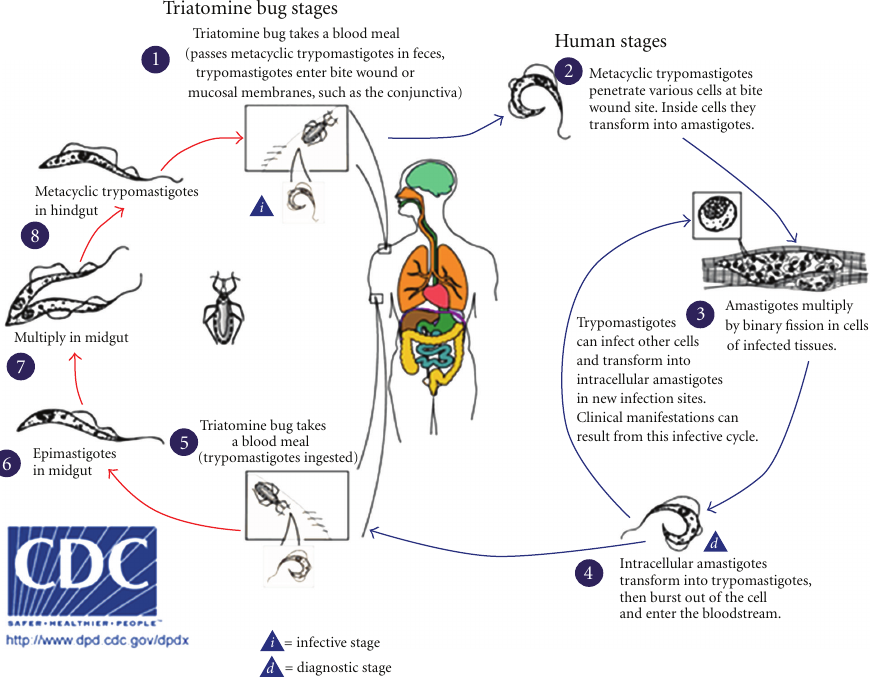
Figure 2: An infected triatomine bug takes a blood meal and releases trypomastigotes in its feces near the site of the bite wound. Trypomastigotes enter the host through the wound (1). Inside the host, the trypomastigotes invade cells near the site of inoculation, where they di ff erentiate into intracellular amastigotes (2). The amastigotes multiply by binary fission and form pseudocysts (3). Following several cycles of division, these cells will asynchronously di ff erentiate into trypomastigotes, which are then released into the circulation as bloodstream trypomastigotes where they can start infecting cells from other tissues (4). The cycle of infection continues as another triatomine bug becomes infected by feeding on human blood containing the circulating parasites (5). The ingested trypomastigotes transform into epimastigotes in the vector’s midgut (6). The parasites multiply in the midgut (7) and di ff erentiate into infective metacyclic trypomastigotes in the hindgut (8). This figure is adapted from http://www.dpd.cdc.gov/dpdx.